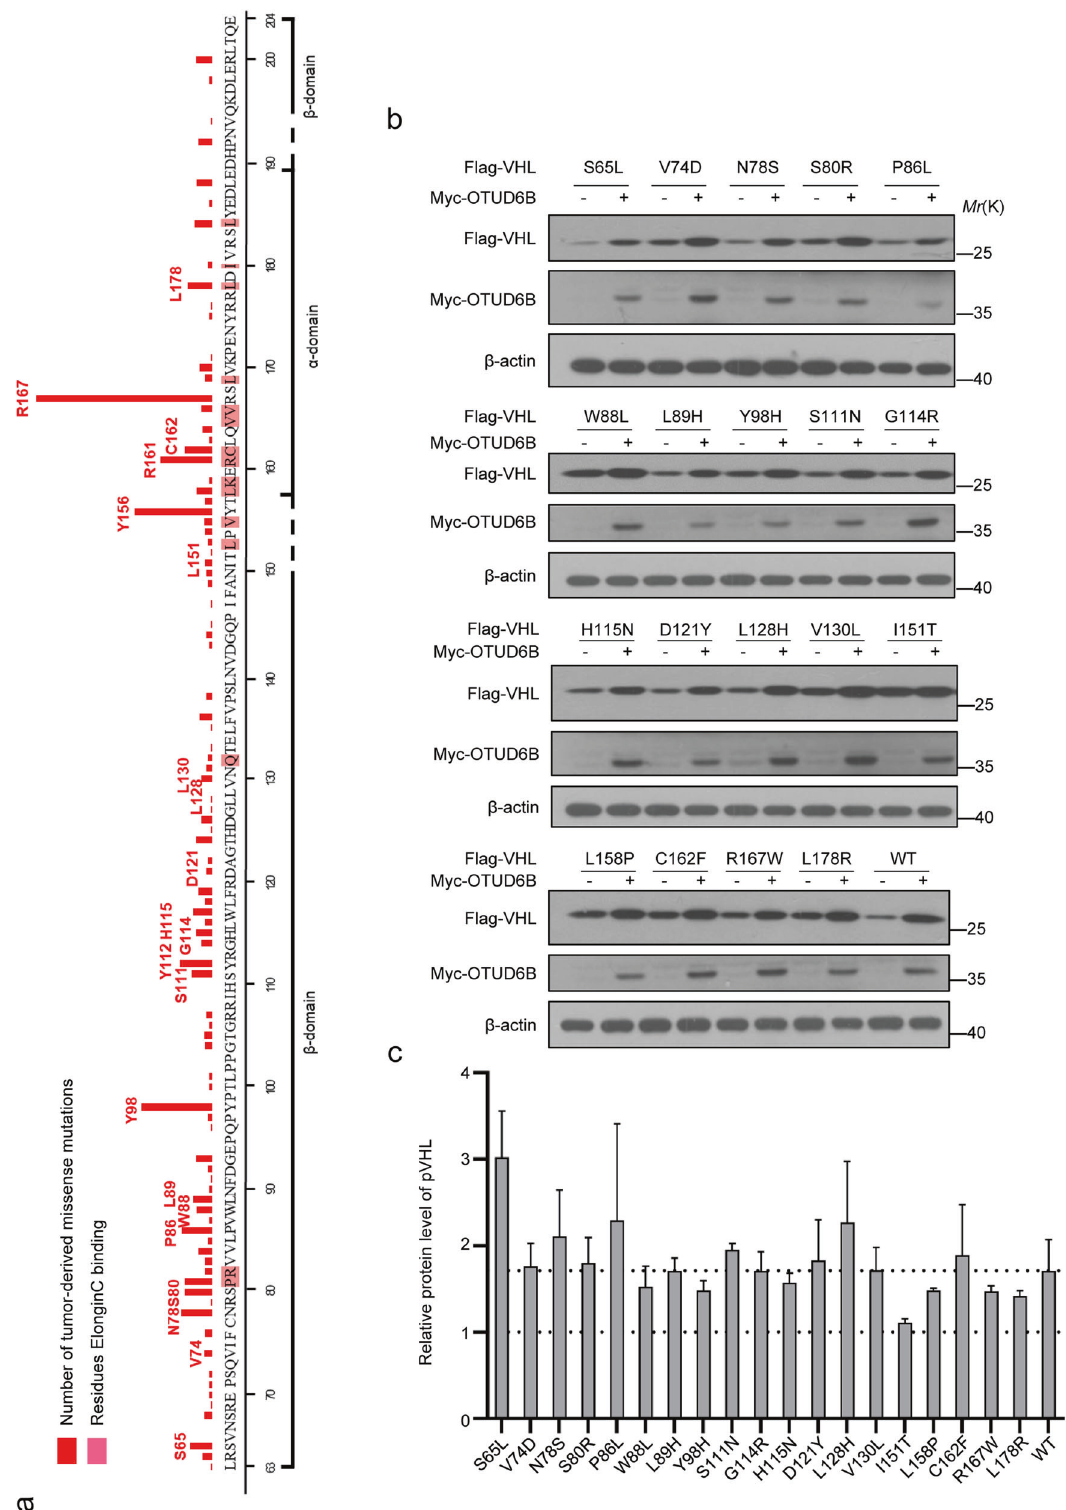
Fig. 4 OTUD6B increases the levels of pVHL mutants. a Missense mutations were located in α and β domains of pVHL. The histogram represents total of 897 missense mutations records in UMD-VHL mutations database. The 19 most frequently mutated amino acids are labeled. b HEK293 cells transfected with indicated pVHL mutants were immunoblotted with anti- fl ag or anti-myc antibodies. c Quanti fi cation of relative levels of pVHL and the mutants are shown. The results are expressed as mean ± sd. Each error bar shows the standard deviations of three independent experimental values. ***, P < 0.001 compared with the level of wild type pVHL, Student ’ s t test.